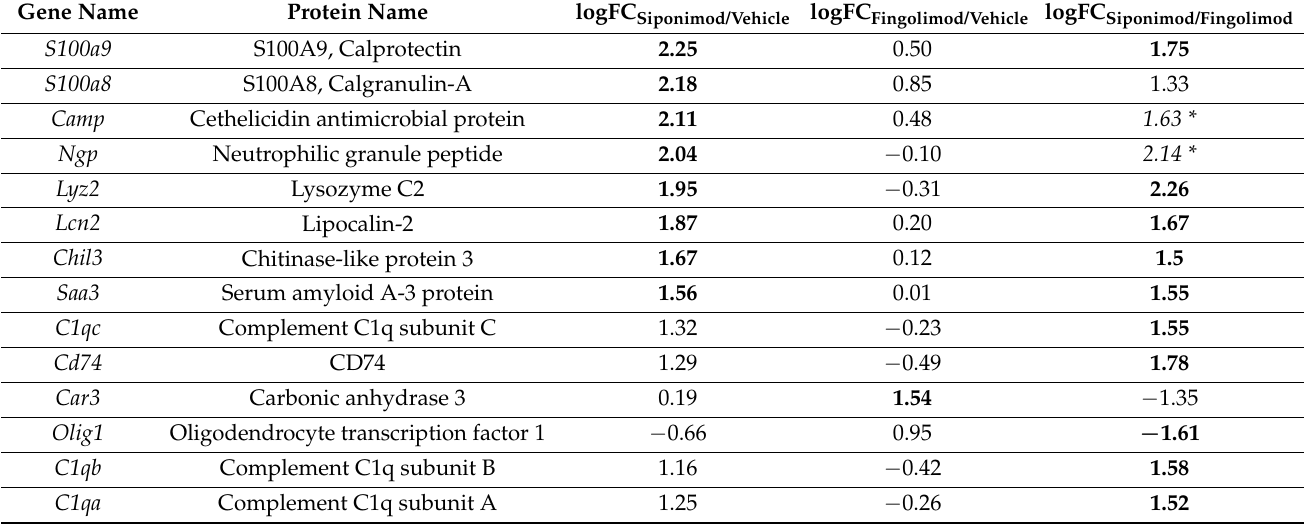
Table 2. LogFC values of genes that passed the > |1.5| threshold in cluster 8 of the spinal